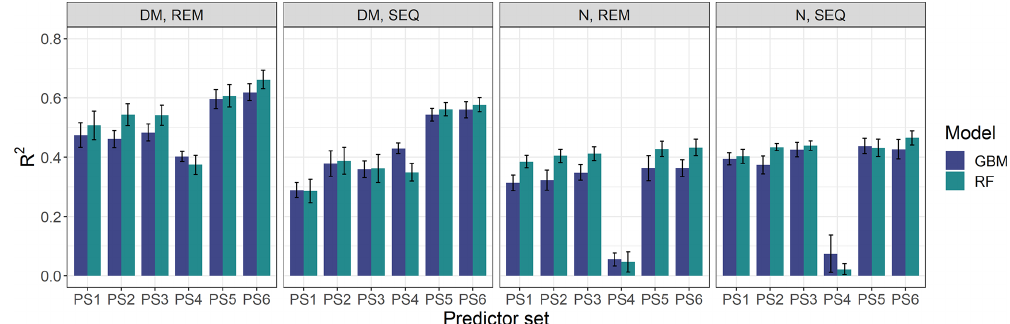
Figure 6. Overview of modelling results for all tested combinations of parameters (DM, plant N concentration), sensors (REM, SEQ), ML algorithms (GBM, RF), and predictor sets (PS1: raw reflectance data, PS2: VI, PS3: raw reflectance data + VI, PS4: canopy height, PS5: raw reflectance data + canopy height, PS6: raw reflectance data + VI + canopy height). The bars show the mean of the cross-validated coefficient of determination ( R 2 ), and the error bars represent ± standard deviation of the 10 iterations per